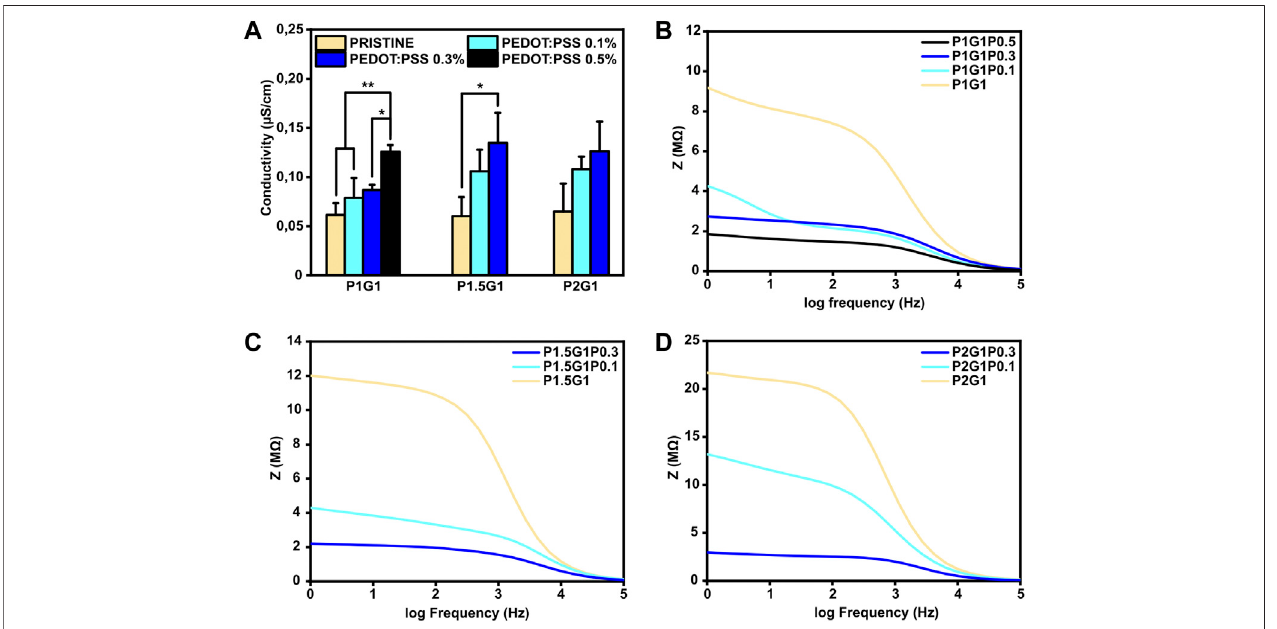
FIGURE6| Electricalcharacterization ofPEGDA-gelatin/PEDOT:PSShydrogelsinadrystate. (A) ConductivityofallthesampleswithdifferentPEGDA:gelatinratio and PEDOT:PSS content measured with a four-point probe. (B) , (C) , (D) Dielectric spectroscopy of P1G1, P1.5G1 and P2G1 samples respectively. * p < 0.05, ** p < 0.01.